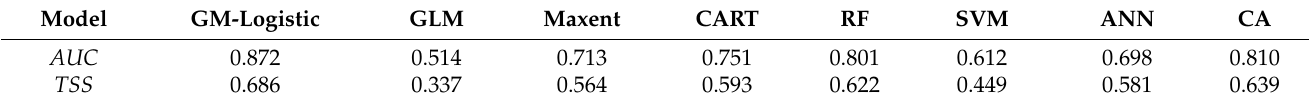
Table 5. Comparison of GM-Logistic model and several classical species distribution models.